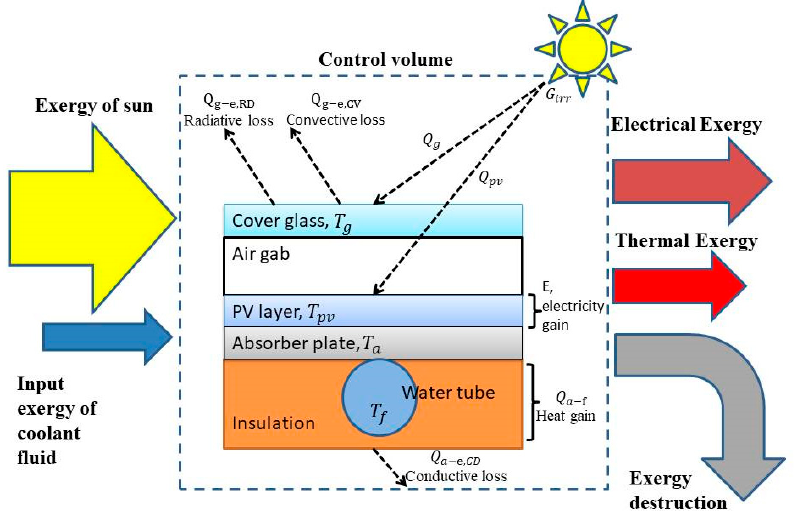
Figure 4. The control volume and exergy flows of the PVT collector model.